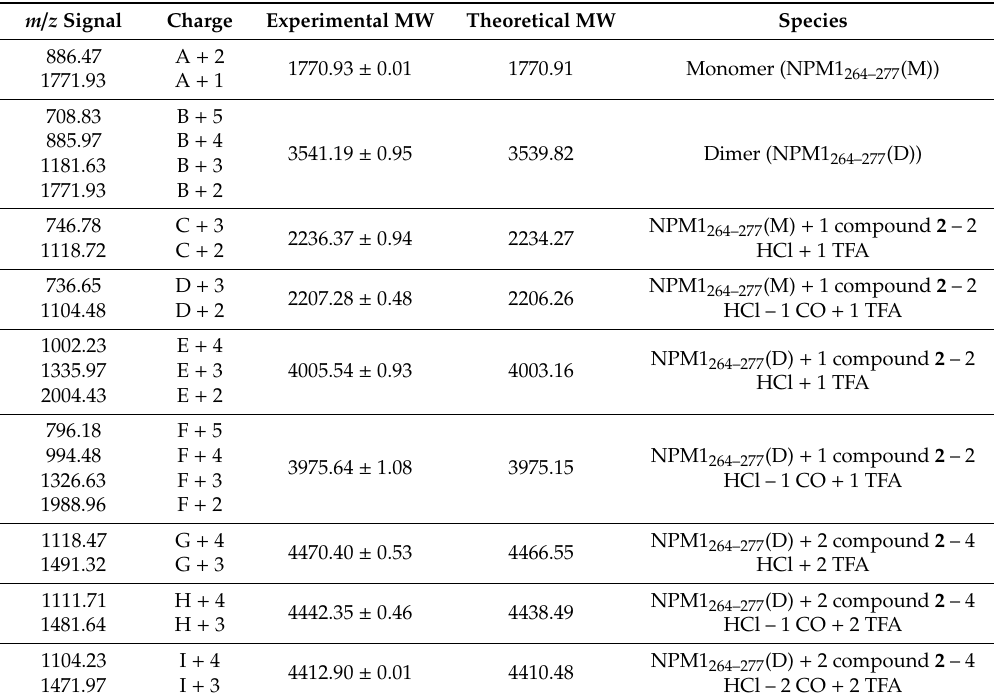
Table 1. ESI-MS detected species formed by NPM1 264–277 and compound 2 at 24 h of incubation. The experimental m / z values and their charge, the experimental and theoretical molecular weight, and the corresponding species are reported. TFA: trifluoroacetate.